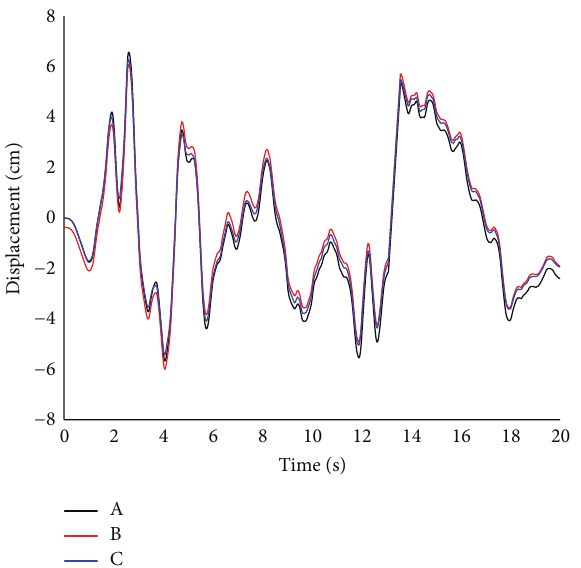
Figure9:Displacementtimecurvesofmonitoringpointsregardless of hydrodynamic pressure.